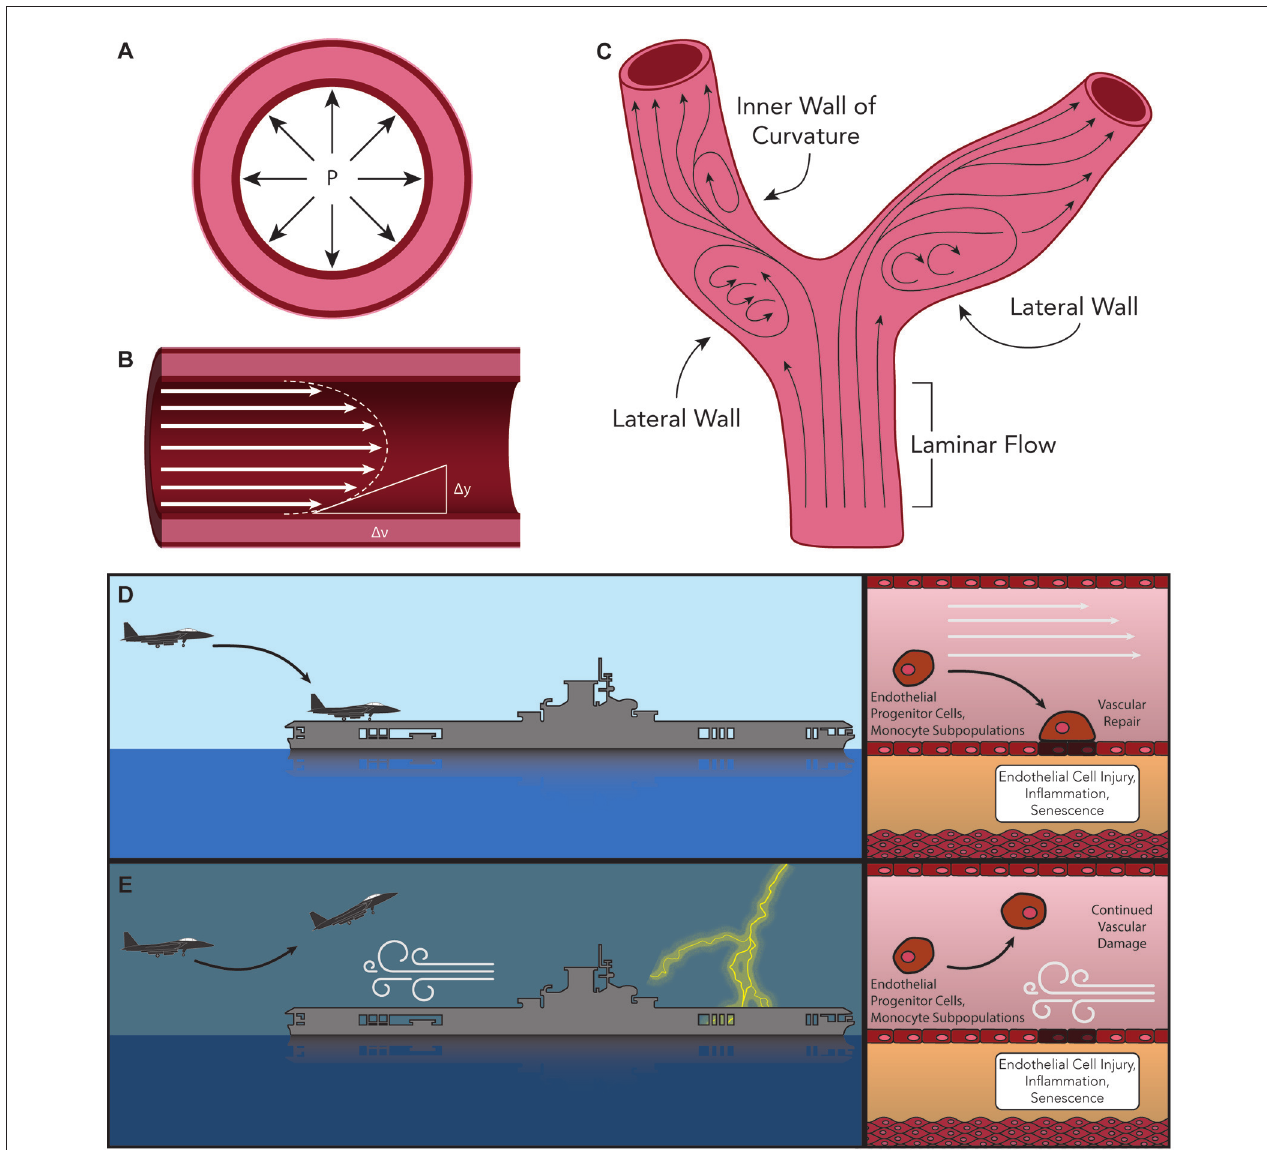
FIGURE 1 | Hemodynamic forces exerted on the arteries. (A) Trans-mural pressure exerted radially across the vessel wall. (B) Endothelial Shear Stress (ESS), determined as the product of blood viscosity ( η ) and its shear rate ( δ v / δ y ) such that ESS = η • ( δ v / δ y ). (C) Typical sites of atherosclerotic plaque formation (lateral walls of bifurcations, inner wall of vessel curvature, and near branch points). Laminar flow in these regions is disrupted, causing oscillatory or reversed flow and subsequent low ESS. Comparison of the ability of bone marrow (BM)-derived vascular progenitor cells and other reparative factors to interact with injured endothelial cells under (D) laminar or (E) turbulent flow can be envisioned as the difference between landing a plane under calm or stormy conditions, respectively.